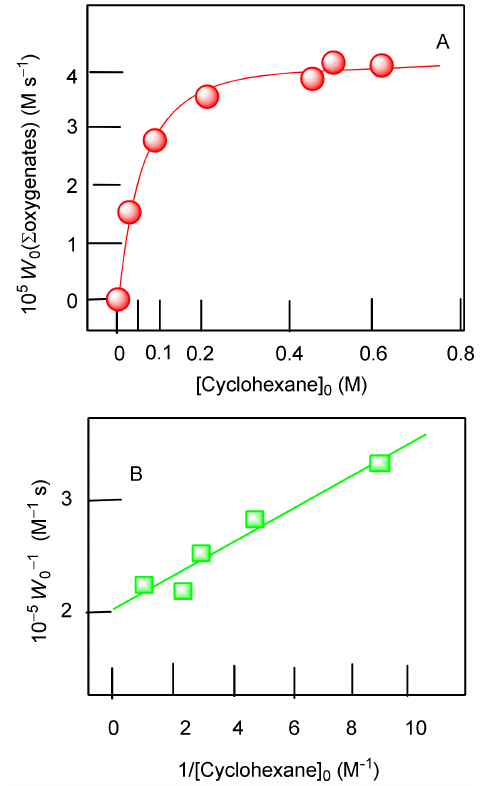
Figure 11. Dependence of the initial rate of oxygenate (sum cyclohexanol + cyclohexanone) for- mation W 0 for complex 2 on the initial concentration of cyclohexane (graph A). Linearization of the curve from graph A in coordinates W 0 − 1 − 1/[C 6 H 12 ] is shown in graph B. Conditions. Concentrations: [1] = 5 × 10 − 4 M, [H 2 O 2 ] 0 = 2.0 M, [HNO 3 ] = 0.05 M, in acetonitrile at 50 ◦ C. Con- centrations of cyclohexanone and cyclohexanol were determined after the reduction of the aliquots with solid PPh 3